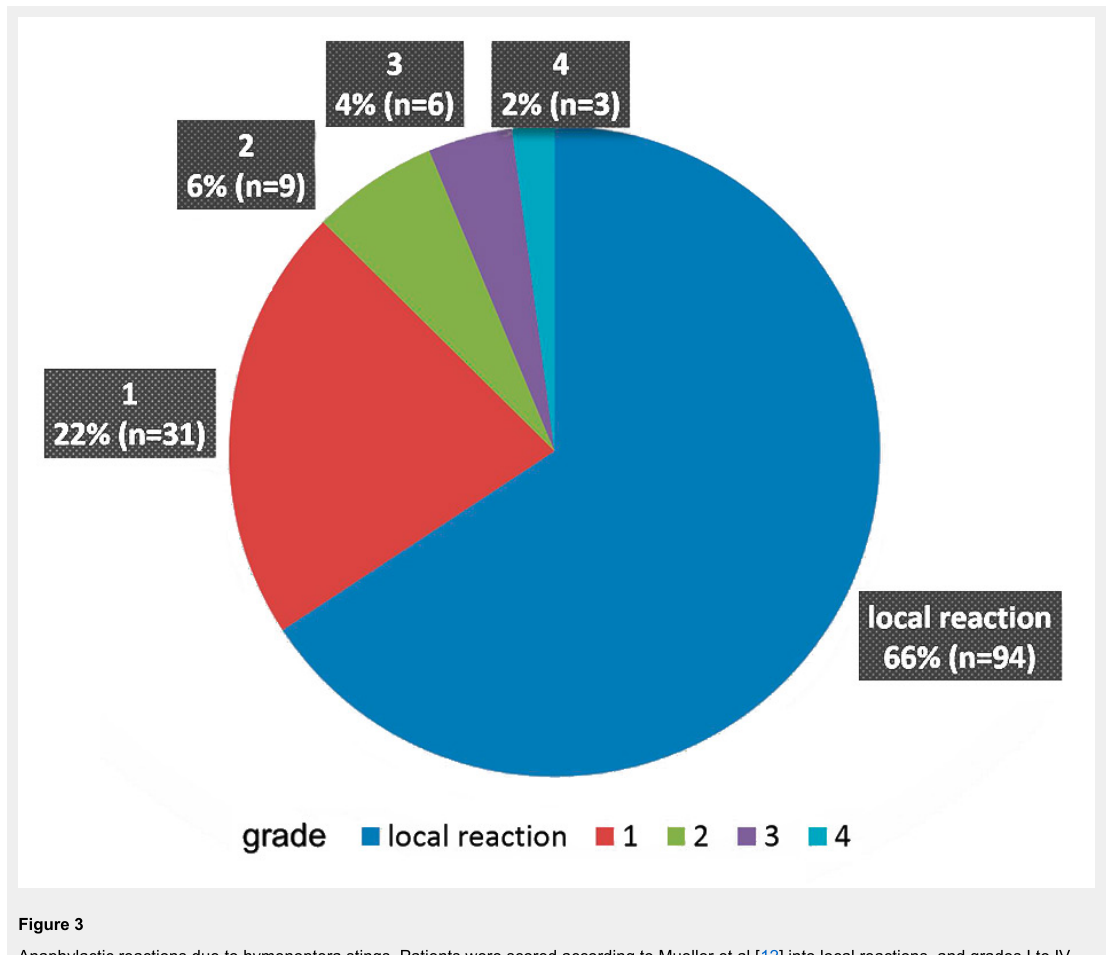
Figure 3 Anaphylactic reactions due to hymenoptera stings. Patients were scored according to Mueller et al [12] into local reactions, and grades I to IV (1–4) anaphylactic reactions.